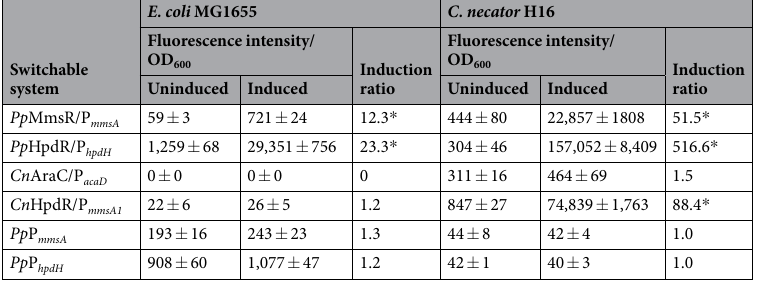
Table 1. Comparison of normalized fluorescence of cells carrying the different versions of putative 3-HP- inducible gene expression systems from P. putida KT2440 ( Pp ) and C. necator H16 ( Cn ) in the presence or absence of 10 mM 3-HP. Each system is composed of either a putative 3-HP-inducible promoter and its respective transcriptional regulator or a 3-HP-inducible promoter only. The mean values and standard deviations represent the normalized fluorescence of biological triplicates six hours after induction for E. coli MG1655 and C. necator H16. Asterisks indicate statistically significant induction values for p < 0.01 (unpaired t